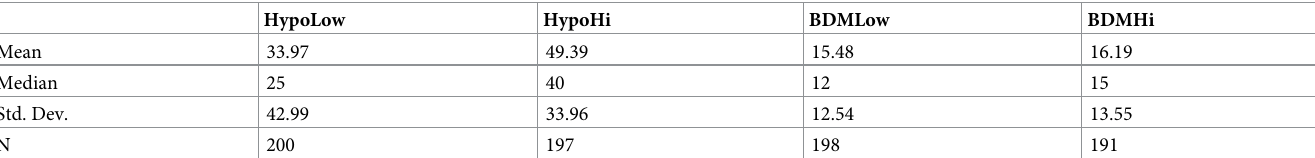
Table 7. Experiment 2: WTPs by treatment (in